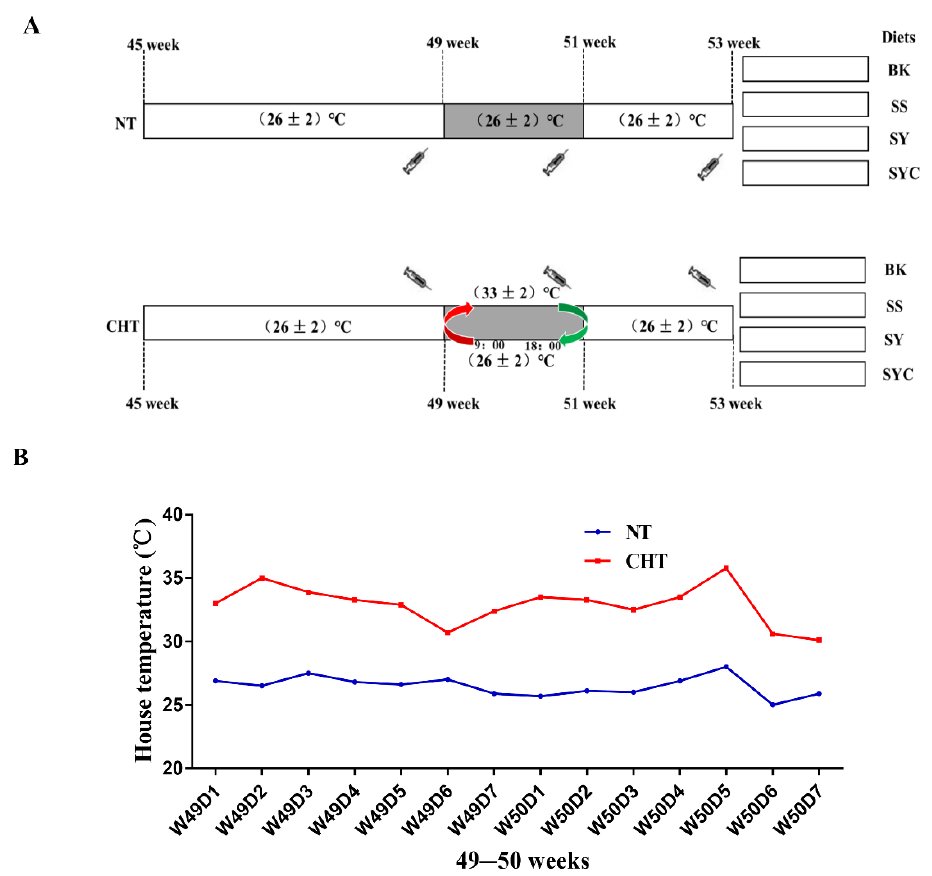
Figure 1. Experimental treatments and timeline of temperature control. ( A ) : blood sampling;